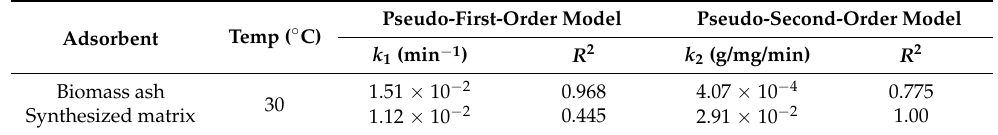
Table 4. Kinetic parameters for biomass ash and the synthesized